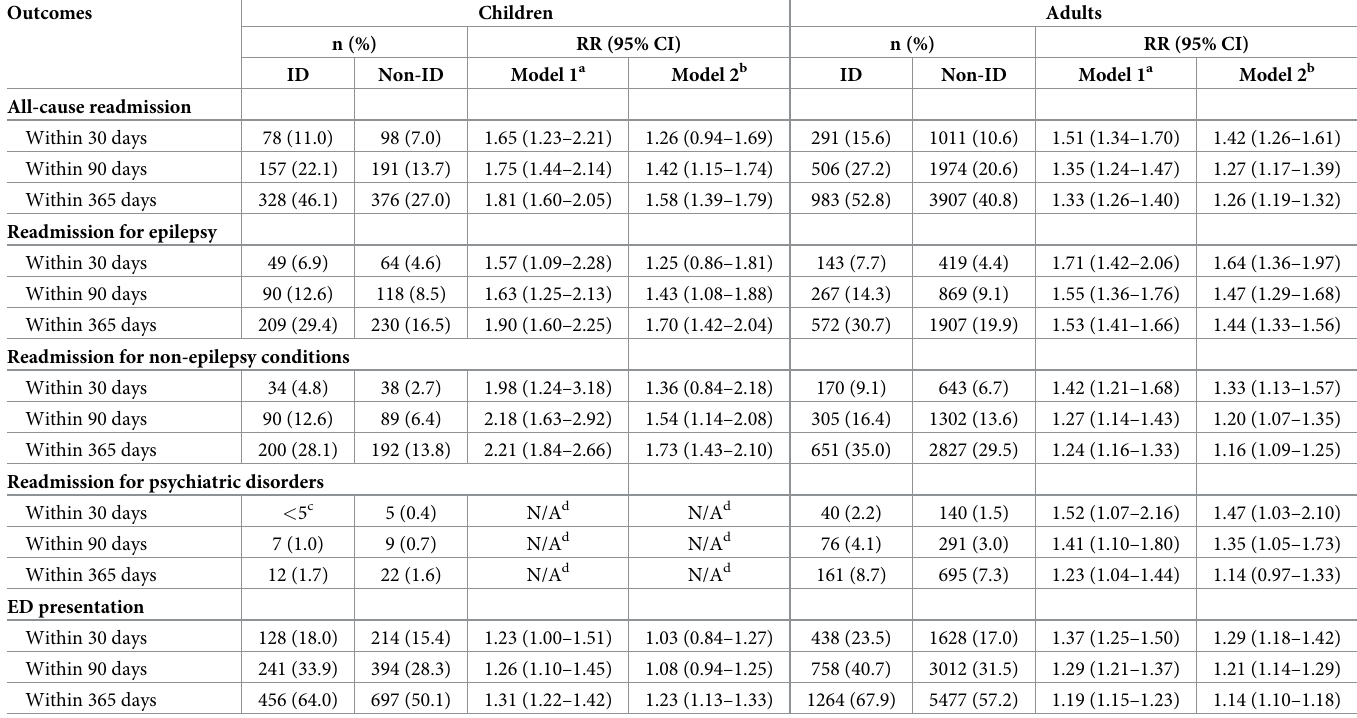
Table 2. Comparison of the proportions of people with and without intellectual disability with at least one outcome within each follow-up period by